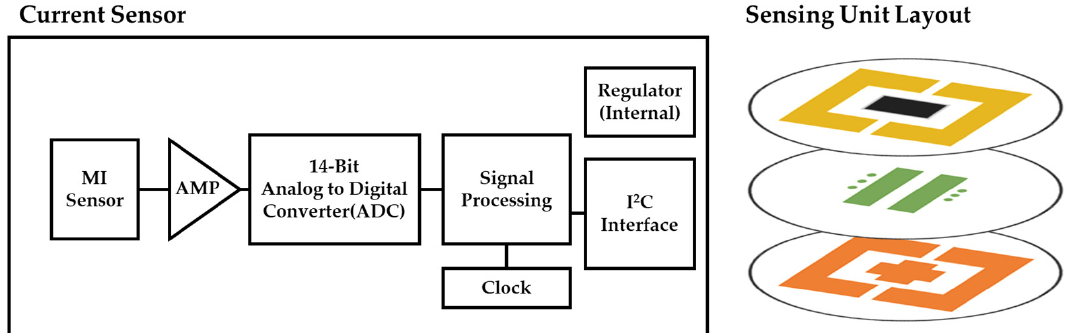
Figure 4. Block diagram of current sensor and PCB layout of sensing unit.